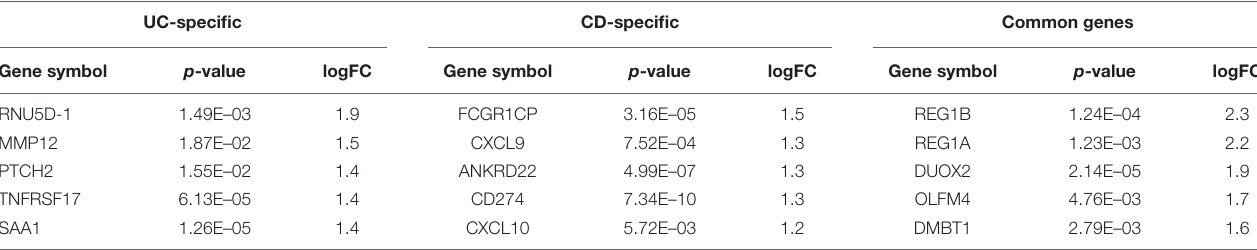
TABLE 2 | Top five upregulated differentially expressed genes (DEGs) and their corresponding p -values and logFC values of the ulcerative colitis-specific, Crohn’s disease-specific, and common genes. UC-specific